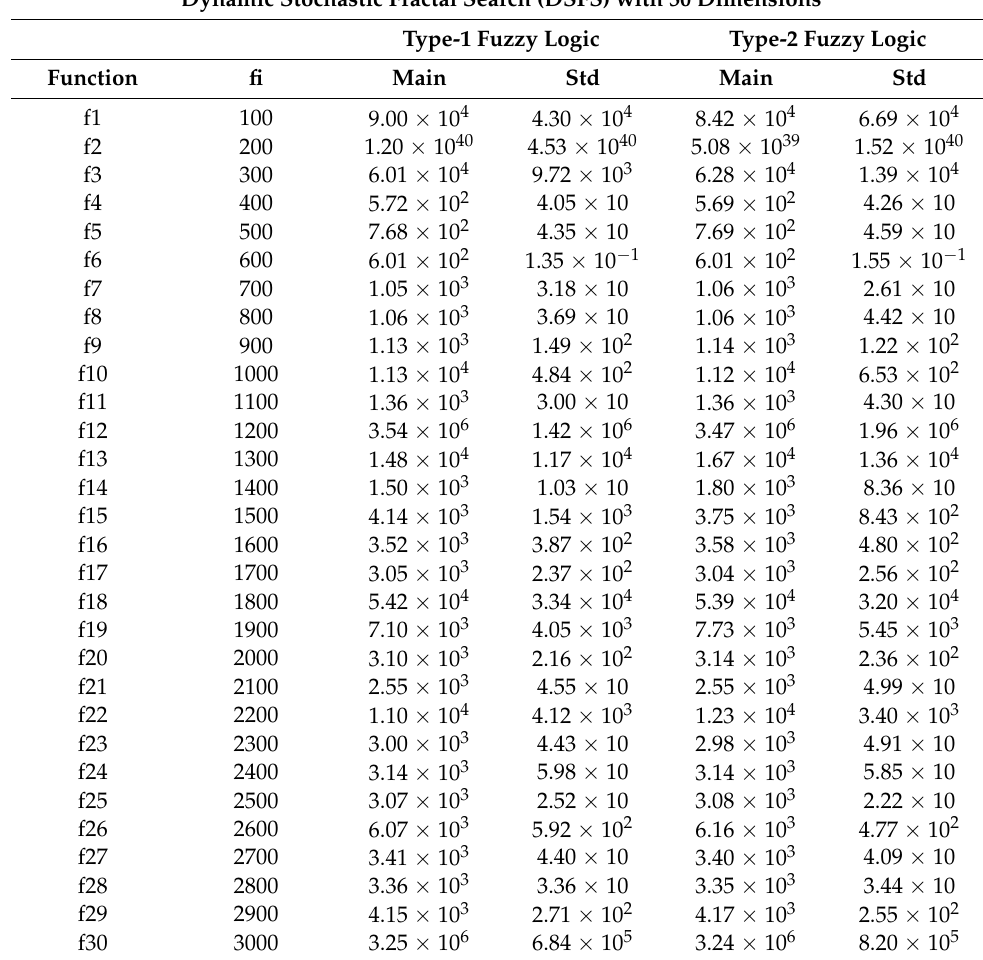
Table 4. Dynamic Stochastic Fractal Search (DSFS) results with 50 dimensions.